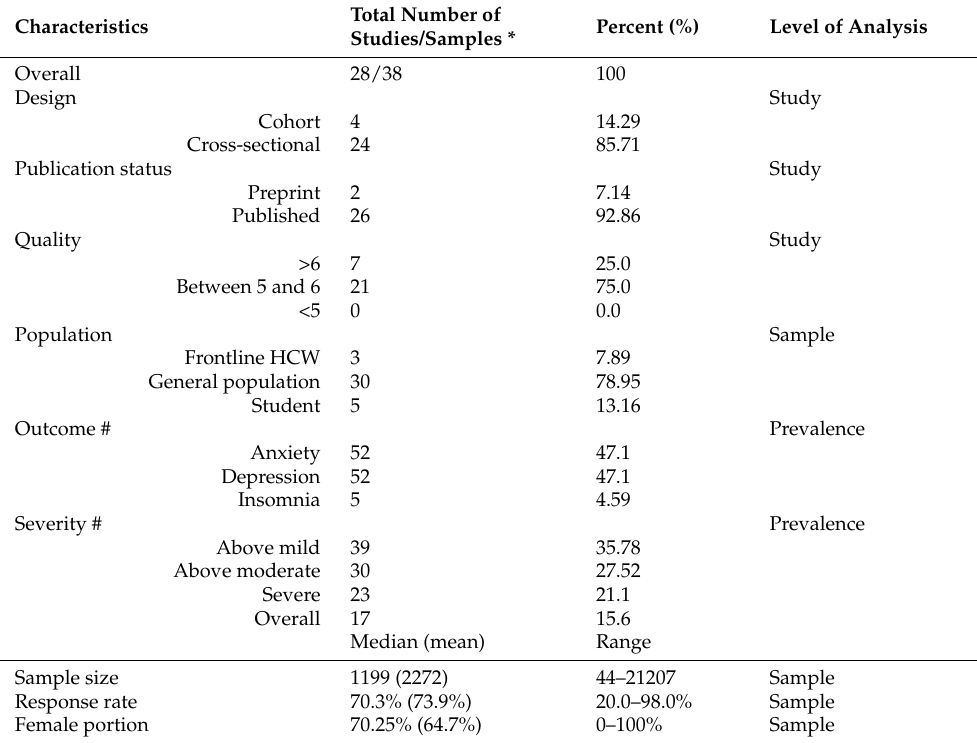
Table 1. Study characteristics for mental health symptoms in COVID-19 epidemic in Spain.